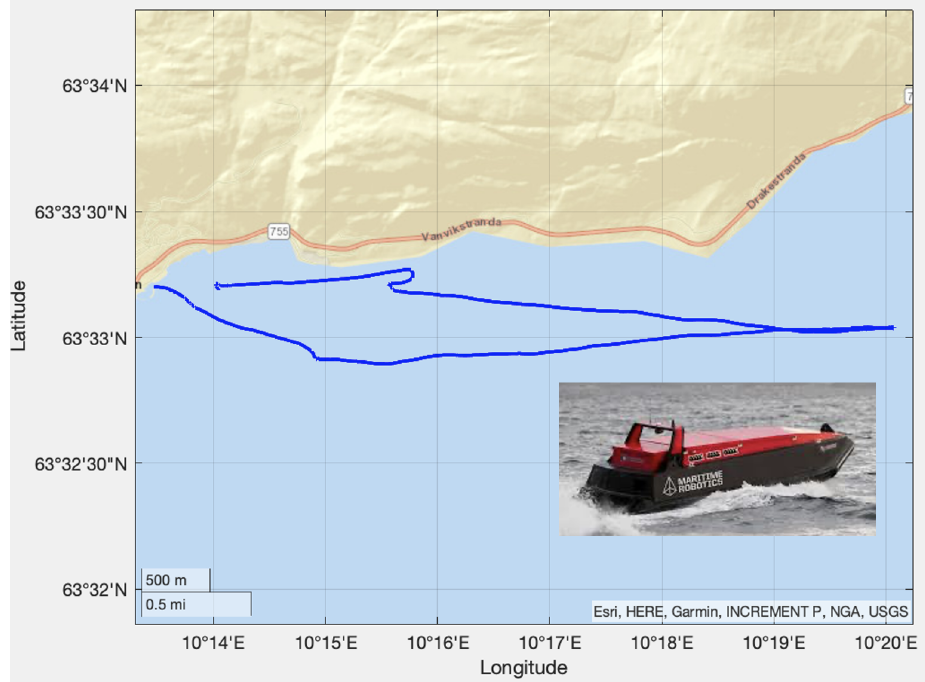
Figure 7. The blue line shows the path of the Mariner USV. The starting point is Vanvikan located north of Trondheim in the Trondheim fjord at 63 ◦ 33 (cid:48) 11.23 (cid:48) N and 10 ◦ 14 (cid:48) 2.90 (cid:48)(cid:48) E .